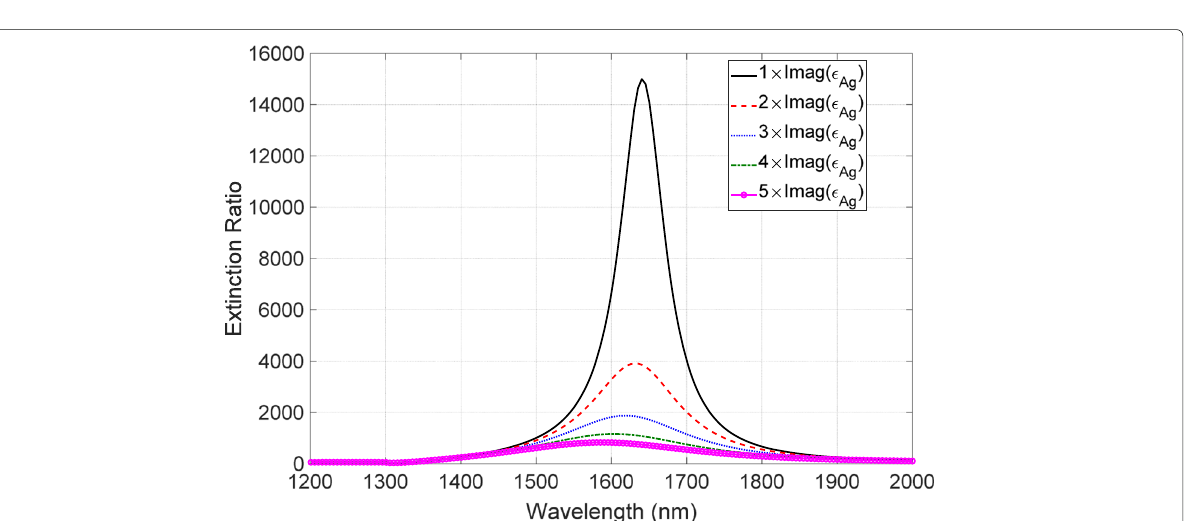
Fig. 12 Metallic loss dependence of the extinction spectra. The black, red, blue, green, and magenta lines correspond to the cases of C = 1,2,3,4, and 5,